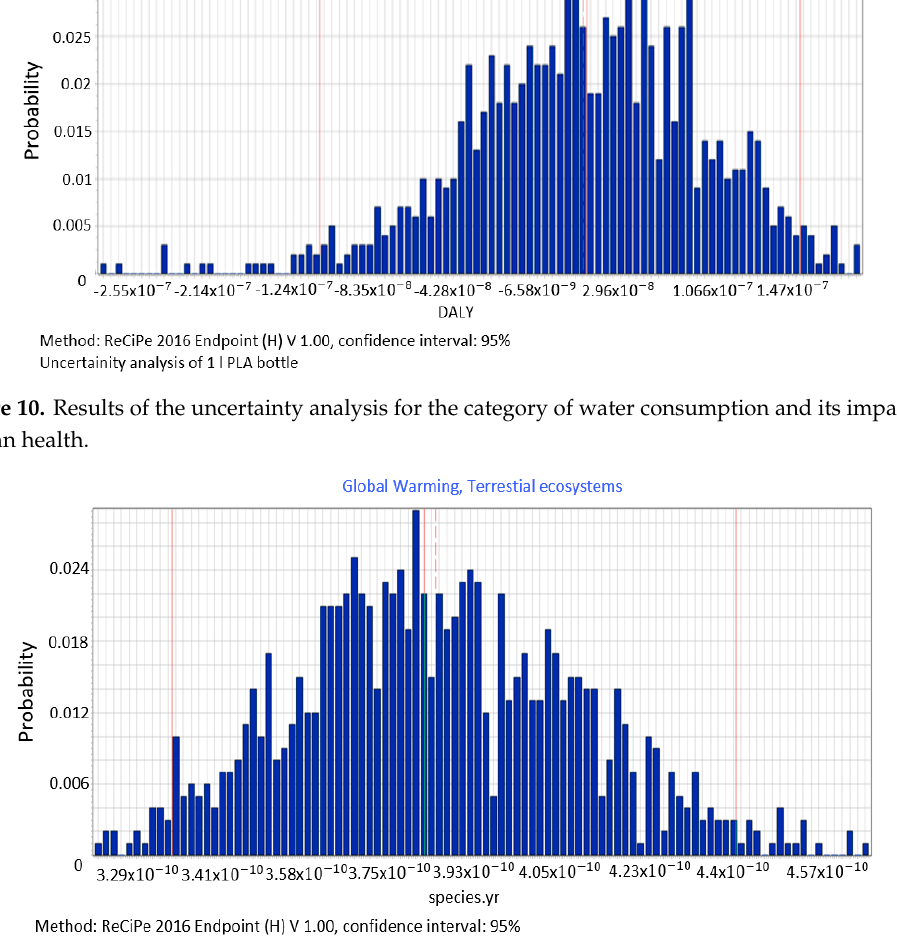
Figure 11. Results of the uncertainty analysis for the category of global warming and its influence on the ecosystem quality.